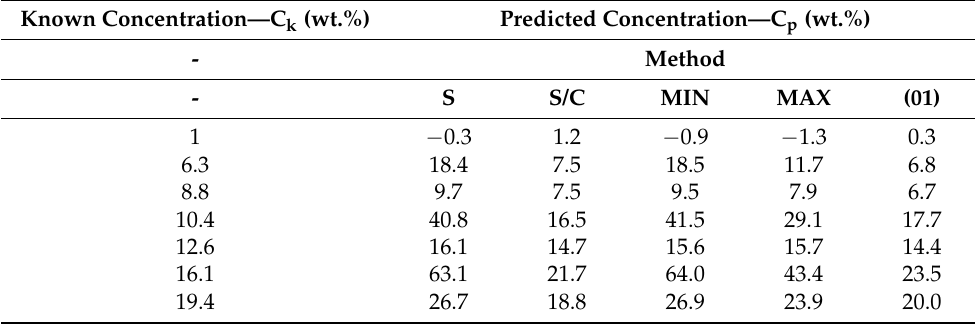
Table 3. Comparison of the known concentrations (C k ) with the predicted ones (C p ).